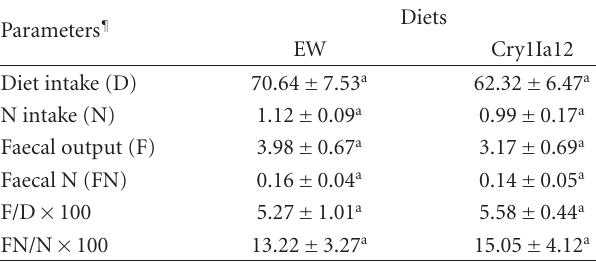
Table 3: Relative faecal dry matter (g) and nitrogen output (g) of rats fed the egg white control (EW) and test diets (Cry1Ia12) calculated for test days 6 to